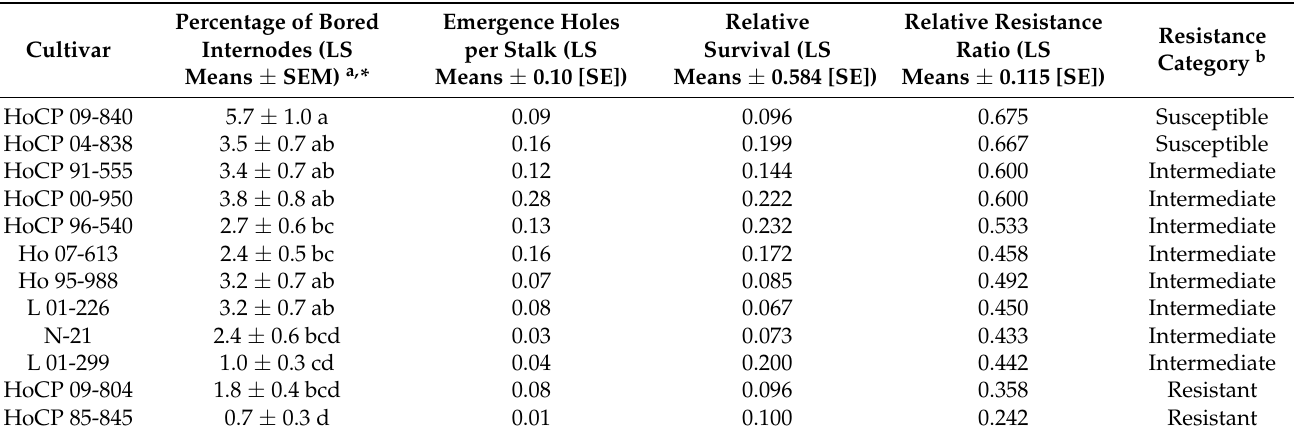
Table 1. Eoreuma loftini injury, survival, and resistance classification among sugarcane cultivars plant cane field trial, Beaumont, TX 2016 [28].